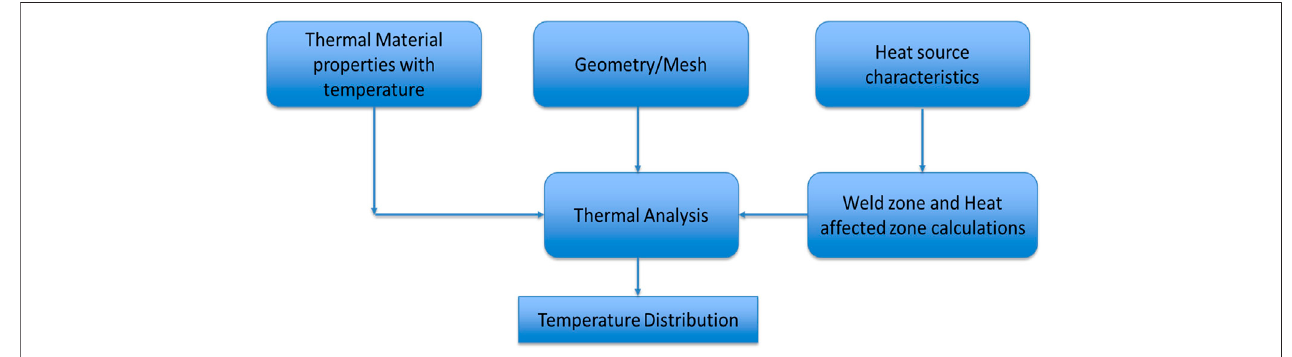
FIGURE 2 | Block diagram for modelling of optical laser transmission welding and analysis for achieving quality